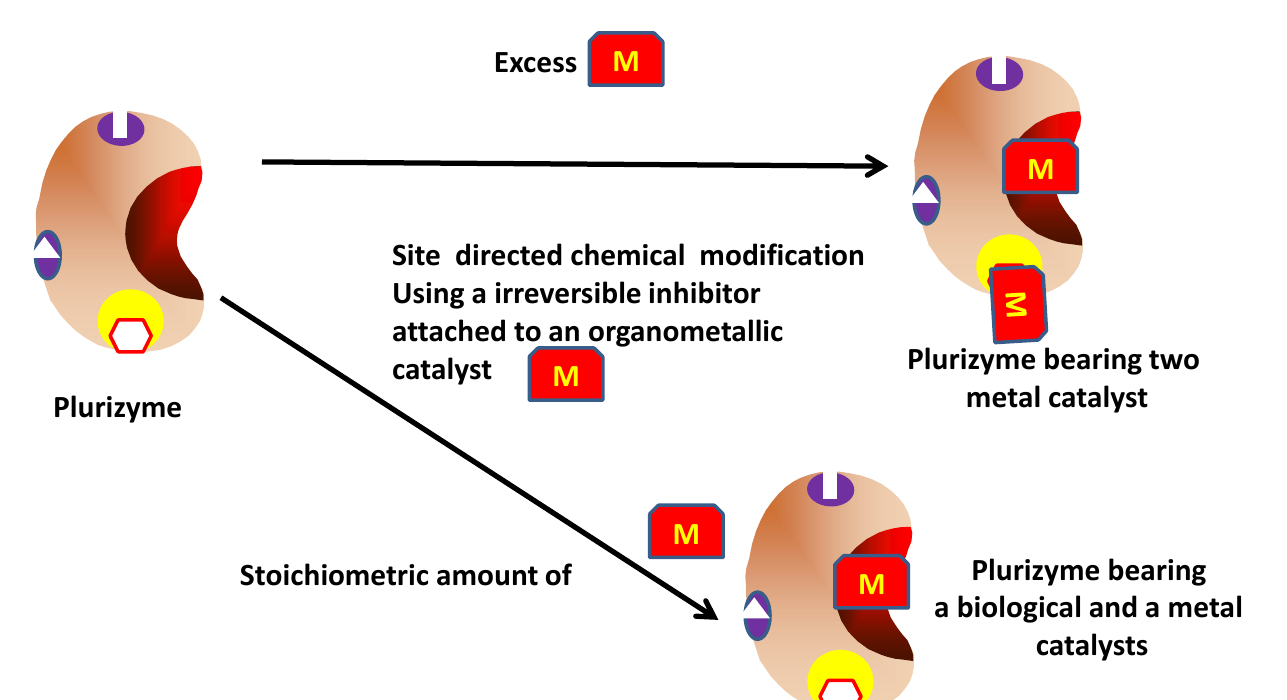
Figure 8. Design and modified plurizymes; single or multiple catalytic